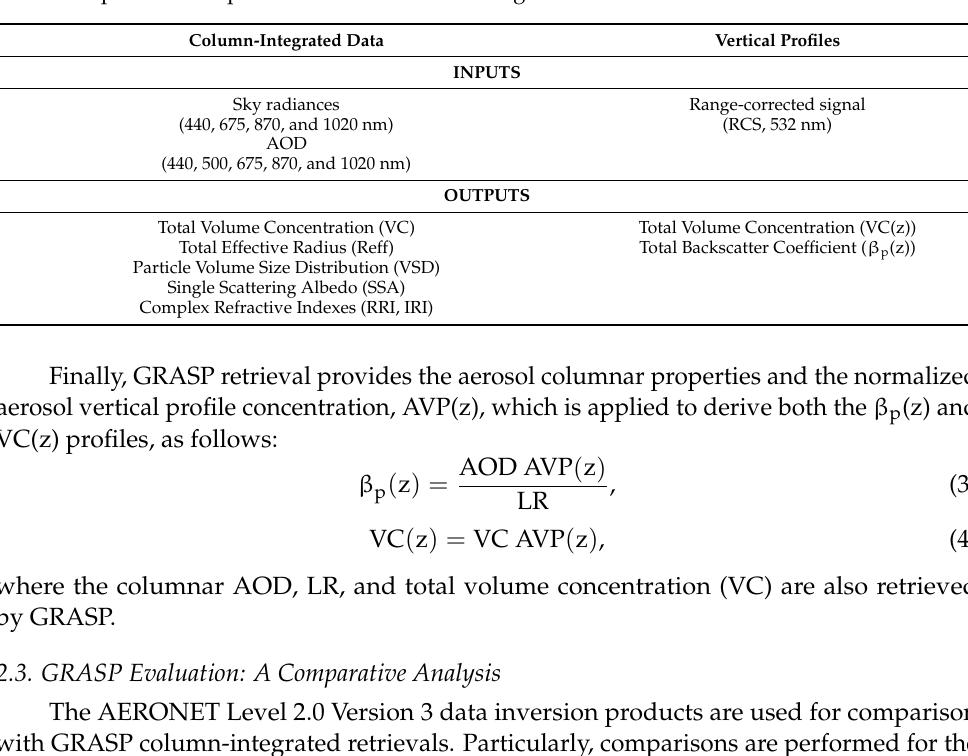
Table 1. Inputs and outputs of the columnar and height-resolved variables used in this